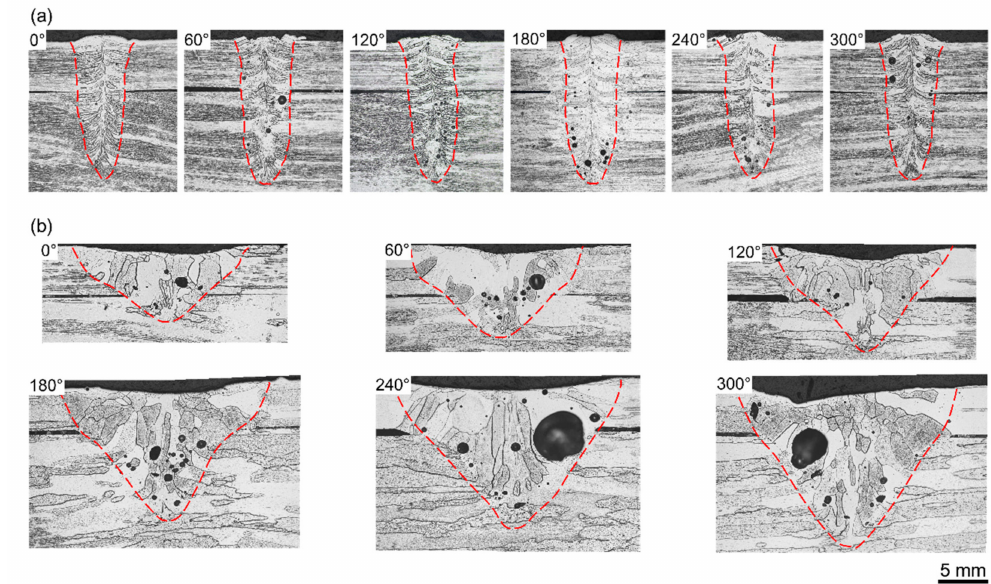
Figure 6. The cross-sectional macrostructure of laser-welded NS Mo alloy joints with: ( a ) heat input of 250 J / cm; ( b ) 3600 J / cm. The fusion lines are marked by red lines.